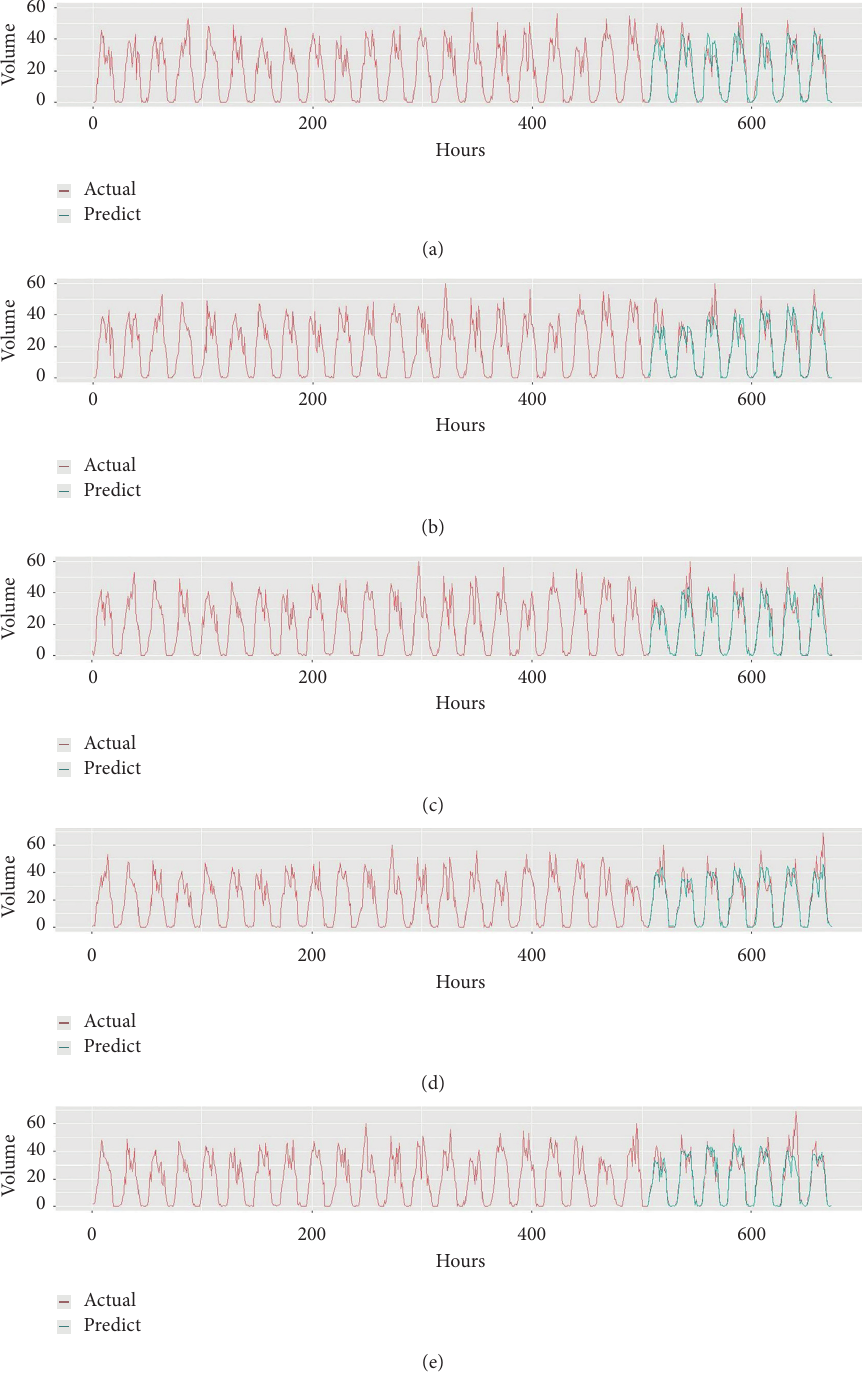
Figure 8: Forecast results of the parking duration category D2 of each slice. (a) D2, slice 2, and MRE: 16.06%. (b) D2, slice 3, and MRE: 19.20%. (c) D2, slice 4, and MRE: 15.93%. (d) D2, slice 5, and MRE: 20.19%. (e) D2, slice 6, and MRE: